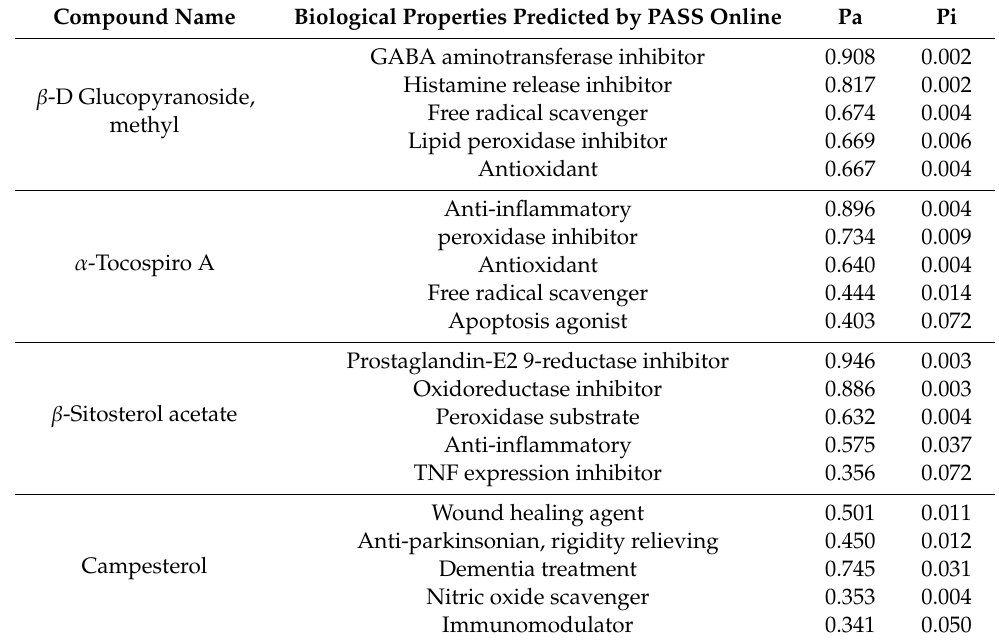
Table 9. Biological activities predicted for Ophiorrhiza rugosa major compounds by Prediction of activity spectra for substances (PASS)